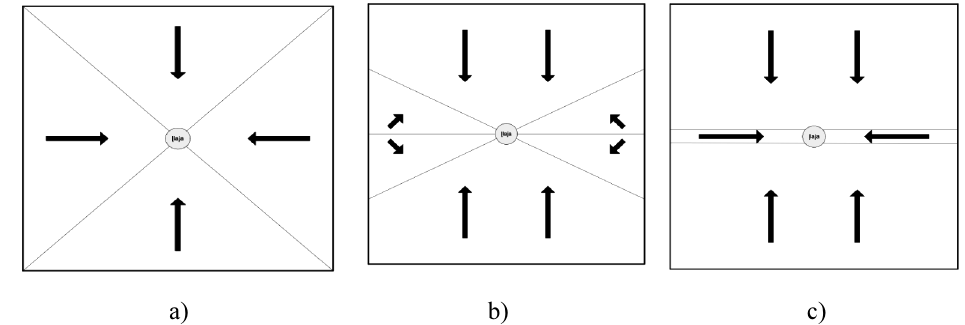
Fig. 10. Possible options for formation of the roof slopes: a) all the same slopes; b) composite slopes; c) confluence in the